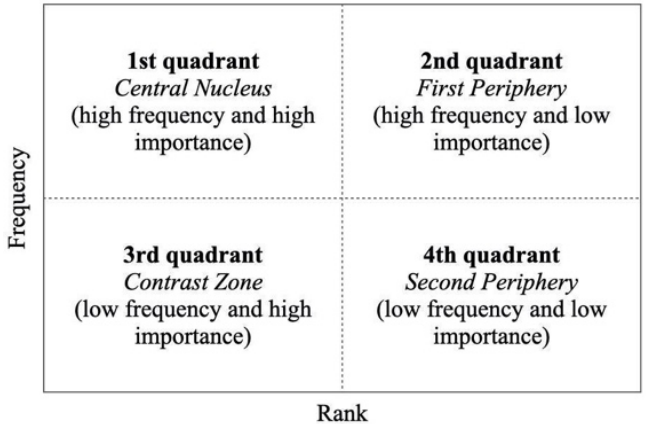
Figure 1. Distribution of the evocations as organized by Abric (2005).